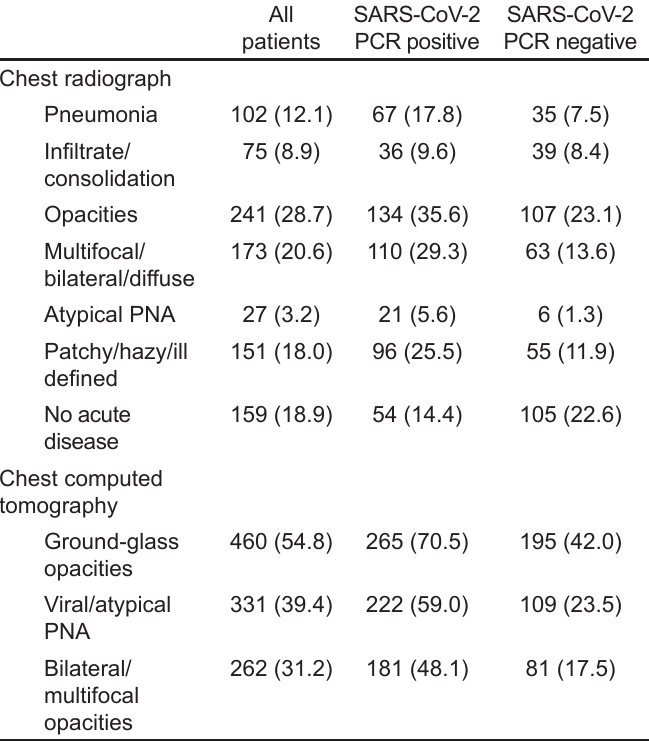
Table 1. Demographics [n (%)] of patients tested for severe acute respiratory syndrome coronavirus 2.